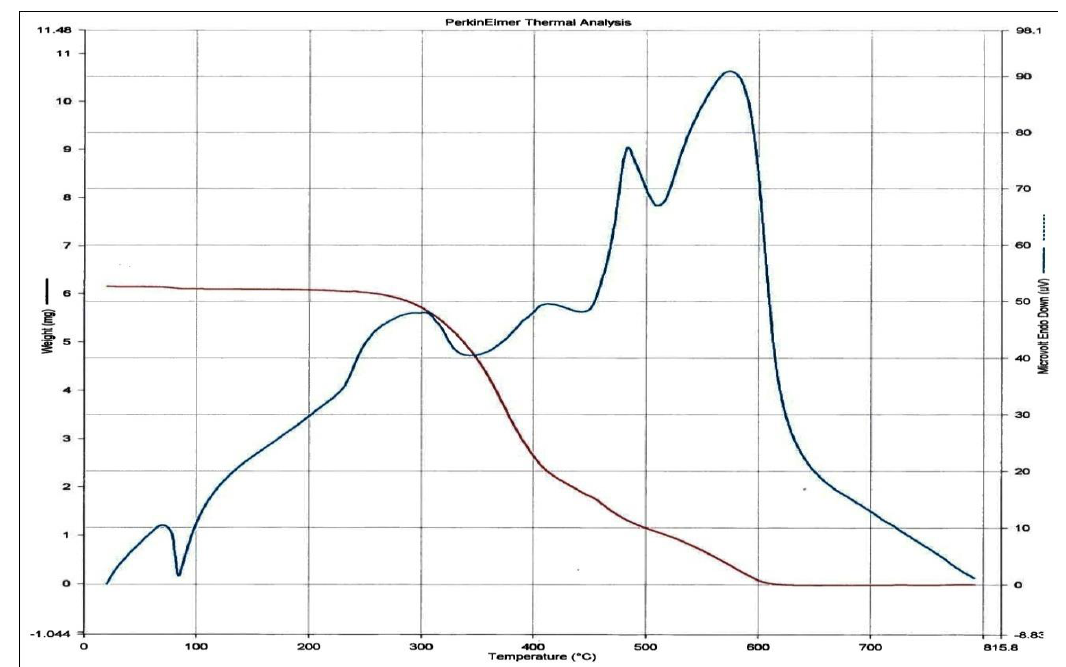
Figure S23: TG/DTA graph of dialdehyde monomer m -HOB